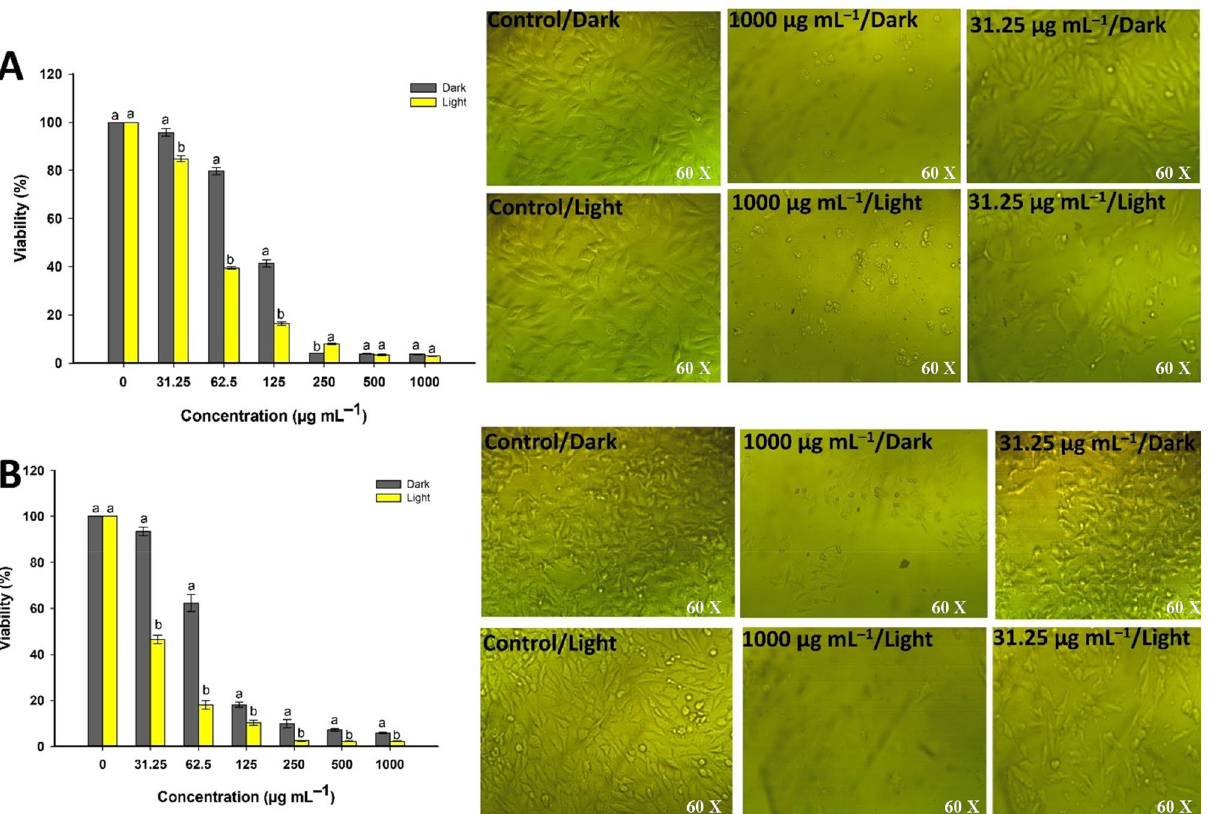
Figure 6. The cell viability and microscopic changes of cancer cells T47D ( A ) and HepG2 ( B ) after treatment with Se-NPs in the presence and absence of light irradiation